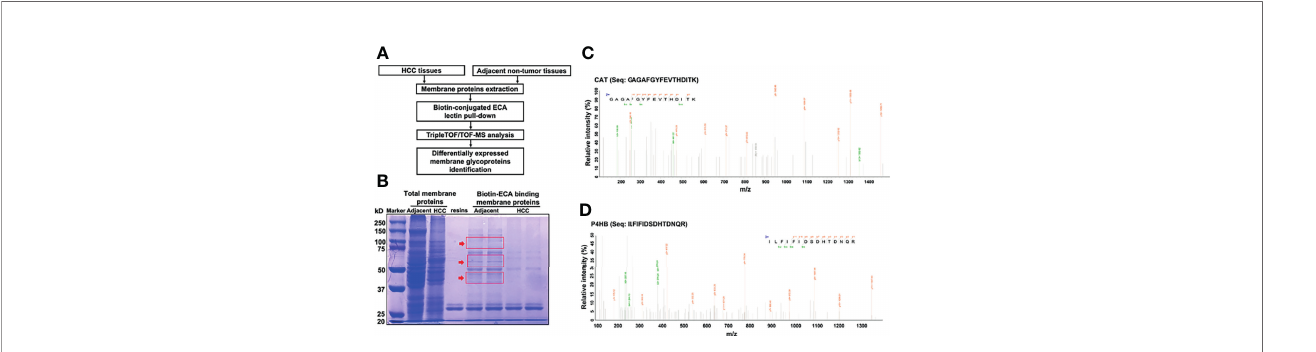
FIGURE 3 | Identi fi cation of signi fi cantly decreased membrane glycoprotein galactosylated CAT and P4HB in HCC tissues with LC-MS/MS. (A) Work fl ow showing the strategy for the identi fi cation of decreased membrane galactosylated CAT and P4HB glycoproteins in HCC tissues. (B) SDS-PAGE analysis of the differential membrane proteins between adjacent non-tumor tissues and HCC tissues pull downed by biotin-conjugated ECA. The differentially expressed membrane protein bands indicated by red arrow were excised for MS analysis. (C) The amino-acid sequence (GAGAFGYFEVTHDITK) from MS is identi fi ed as CAT. (D) The amino-acid sequence (ILFIFIDSDHTDNQR) from MS is identi fi ed as